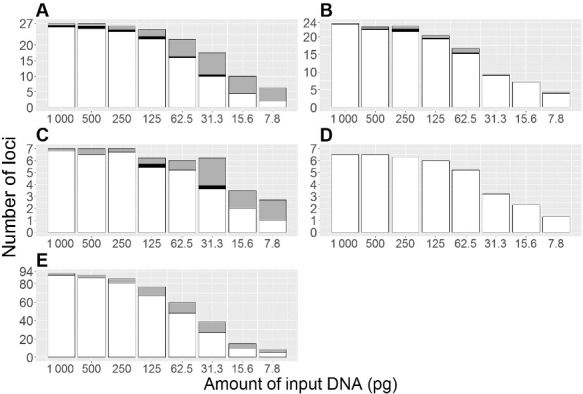
Sensitivity study. DNA extracts from two males and two females were serially diluted and typed in triplicate. The amount of DNA in the first PCR was 1 000, 500, 250, 125, 62.5, 31.3, 15.6 and 7.8 pg, respectively. The average number of correctly typed loci (white), loci typed with allele drop-in (black) and loci typed with allele drop-out (grey) is shown for autosomal STRs (A: 27 loci), Y-STRs (B: 24 loci), X-STRs in female samples (C: 7 loci), X-STRs in male samples (D: 7 loci) and HID-SNPs (E: 94 loci). Two different amplicons were generated from each of the loci: DYS385a/b and DYF387S1. Y-STR allele drop-out refers to the drop-out of one of these alleles.